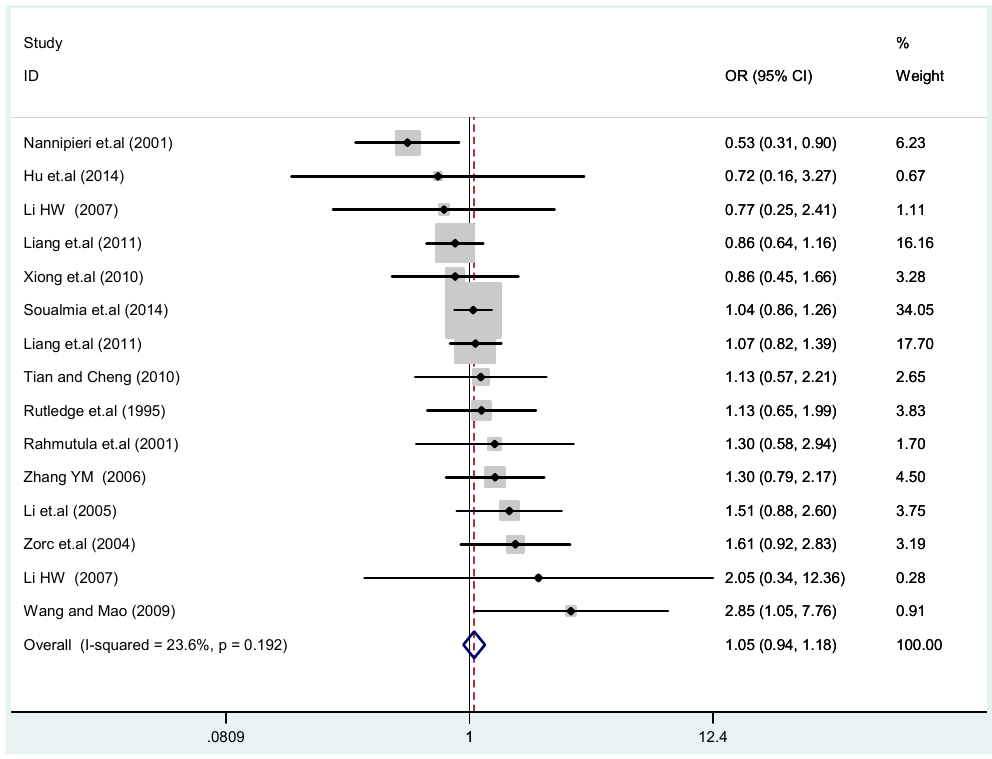
Overall (I-squared = 23.6%, p = 0.192)